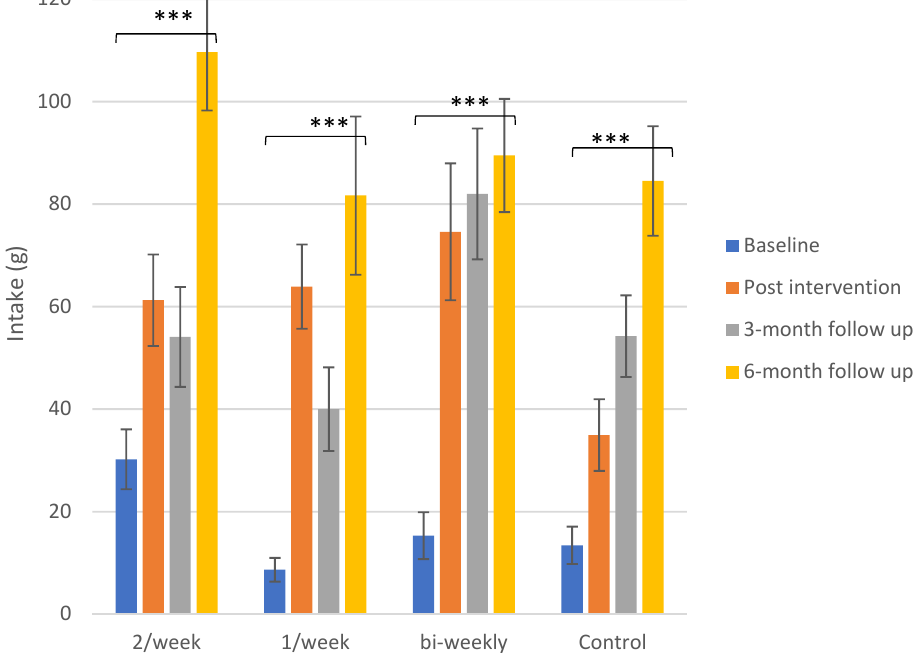
Figure 2. Mean intake scores ± SEM in g of daikon for the different exposure groups for the control visits. The significance of the overall differences only (baseline to 6-month follow-up) for the groups of 2/week, 1/week and bi-weekly exposure and the control group is depicted. The detailed differences and their statistical significance are given in the text. Significance levels: ‘***’: ≤ 0.001.